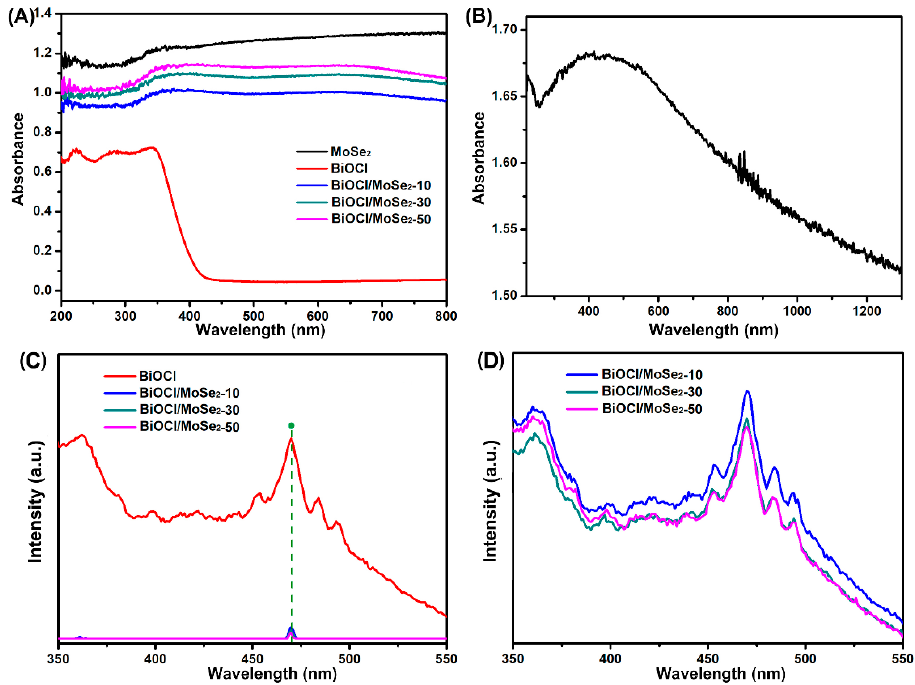
Figure 3. ( A ) UV − Vis DRS spectra of MoSe 2 , BiOCl, BiOCl/MoSe 2 -10, BiOCl/MoSe 2 -30, and BiOCl/MoSe 2 -50 in the UV and visible light region. ( B ) DRS spectra of MoSe 2 in the UV, visible light, and NIR region. ( C ) PL spectra of BiOCl, BiOCl/MoSe 2 -10, BiOCl/MoSe 2 -30, and BiOCl/MoSe 2 -50. ( D ) Enhanced PL spectra of BiOCl/MoSe 2 -10, BiOCl/MoSe 2 -30, and BiOCl/MoSe 2 -50.